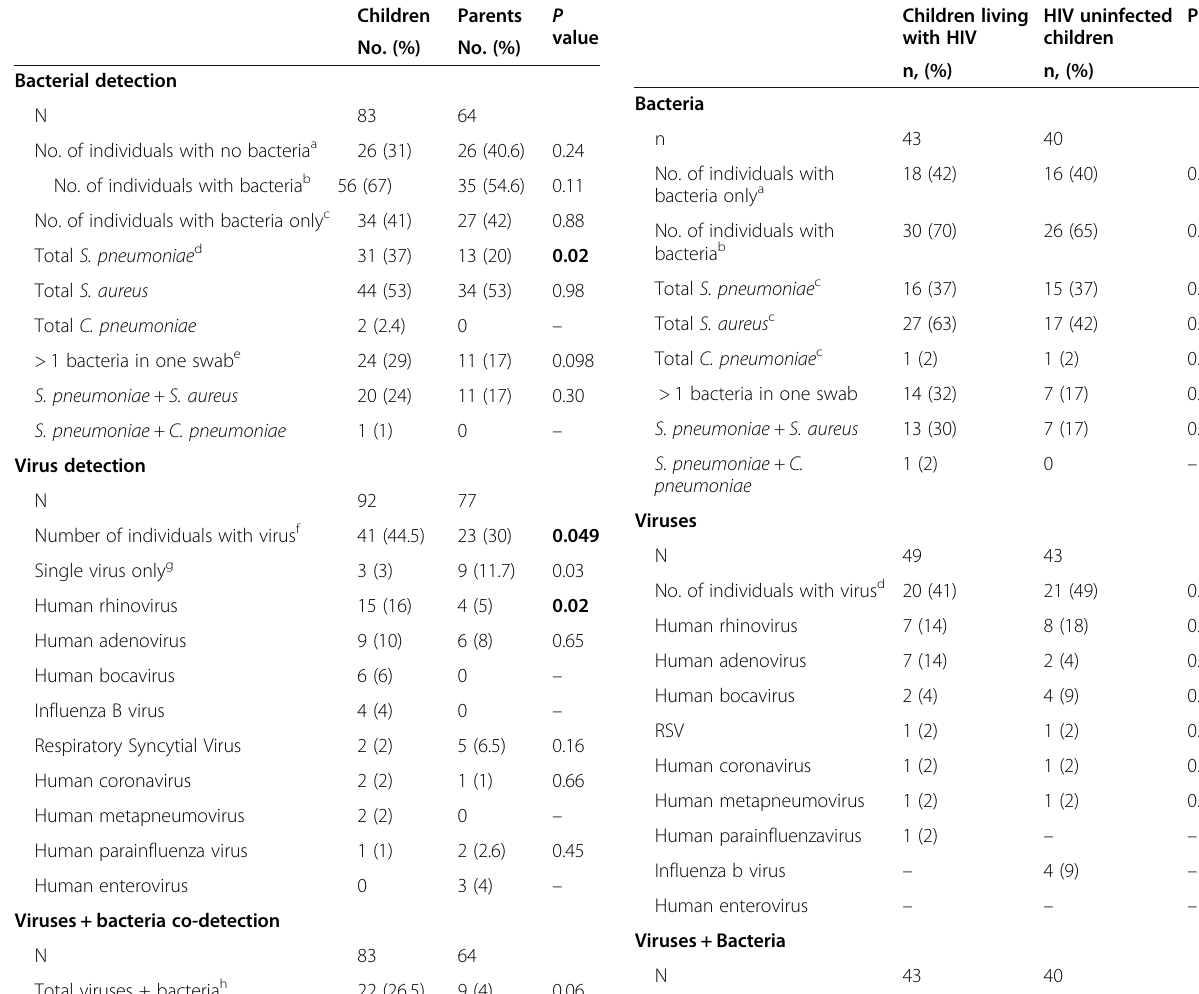
Table 3 Nasopharyngeal bacteria and viruses identified in children and their parents